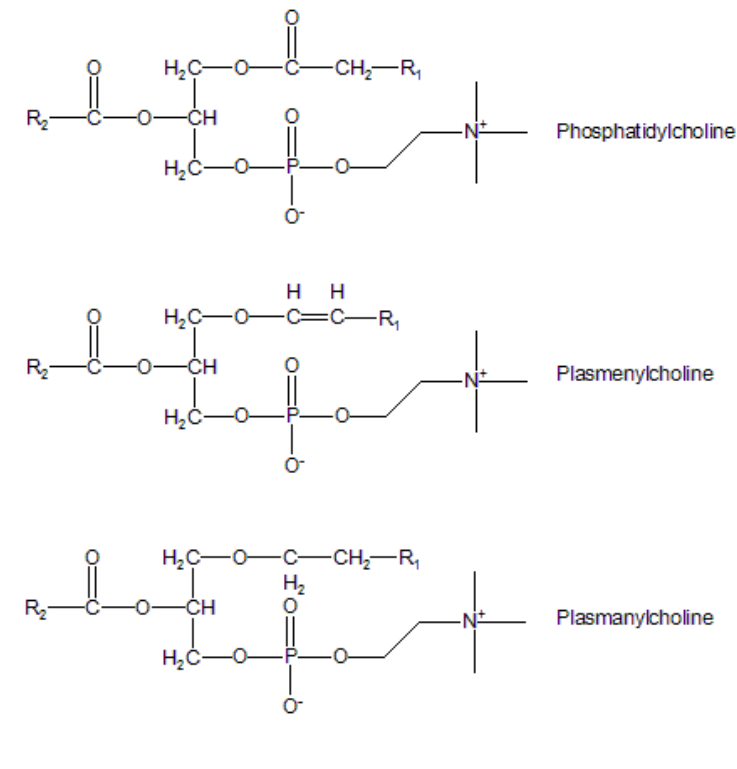
Figure 2. The subclasses of choline glycerophospholipids. Classification based on the linkage of aliphatic chain at the sn-1 position of the glycerol